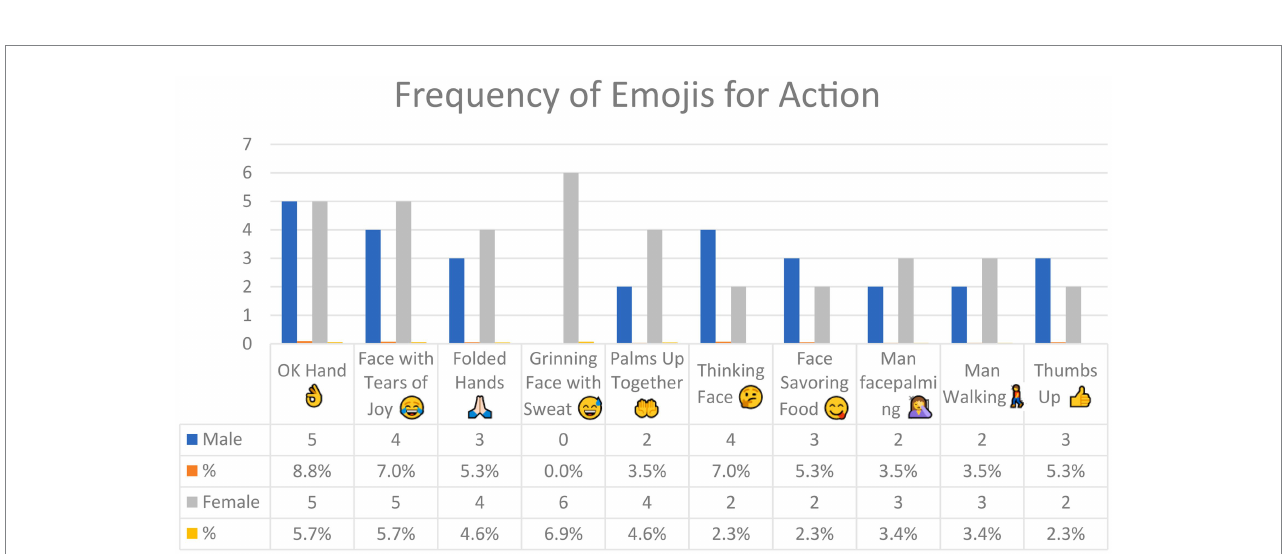
FIGURE 6 The most common emojis used for Action in Arabic